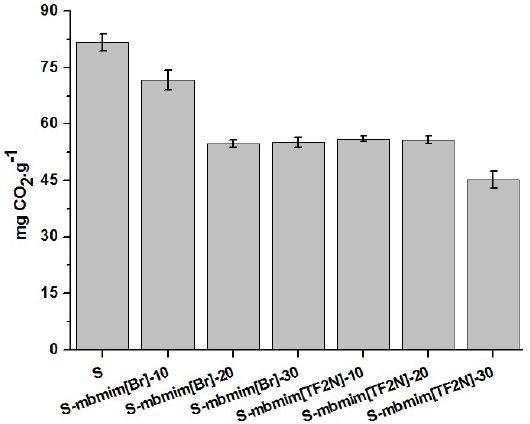
sorption capacity at 0.4 MPa and 45°C. Figure 5. CO 2